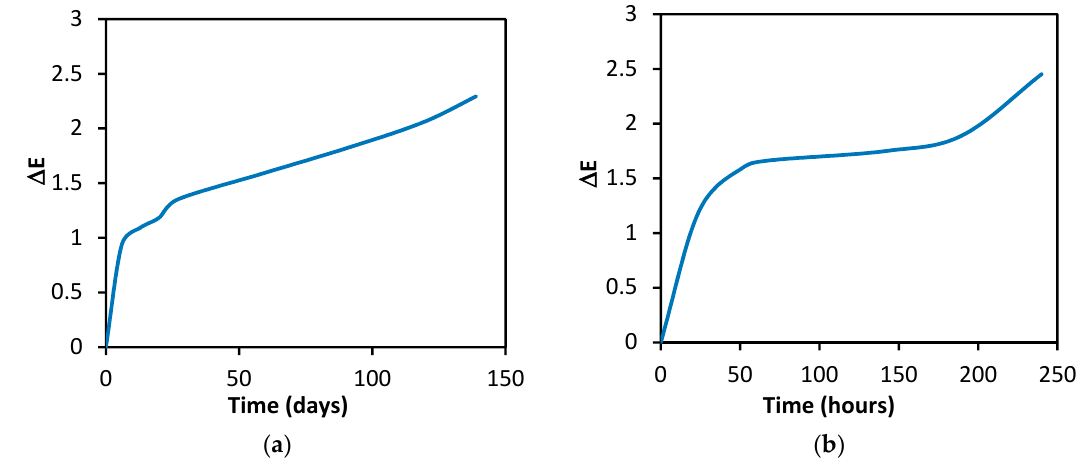
Figure 6. Spontaneous decrease in the color intensity of the filter paper with the substrate and Guinea Green B. Stored ( a ) in normal laboratory conditions, and ( b ) in a drying room at 60 °C.